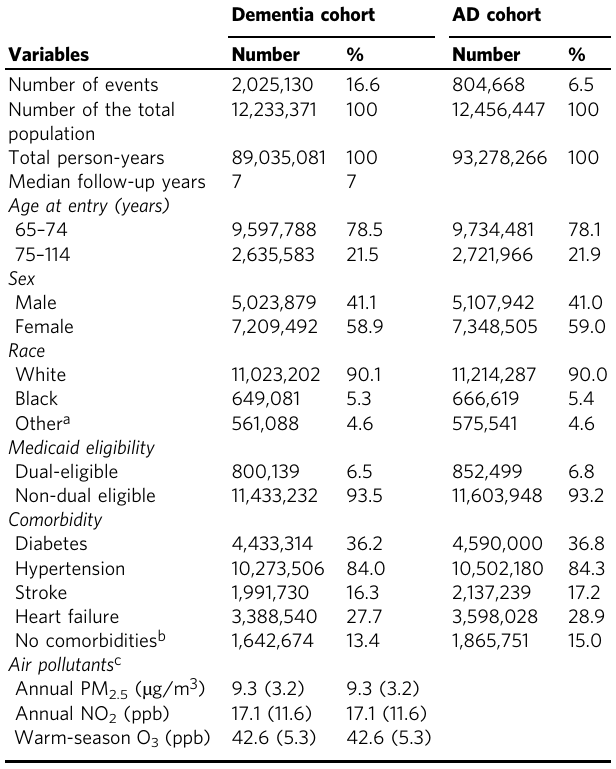
Table 1 Descriptive statistics for the study